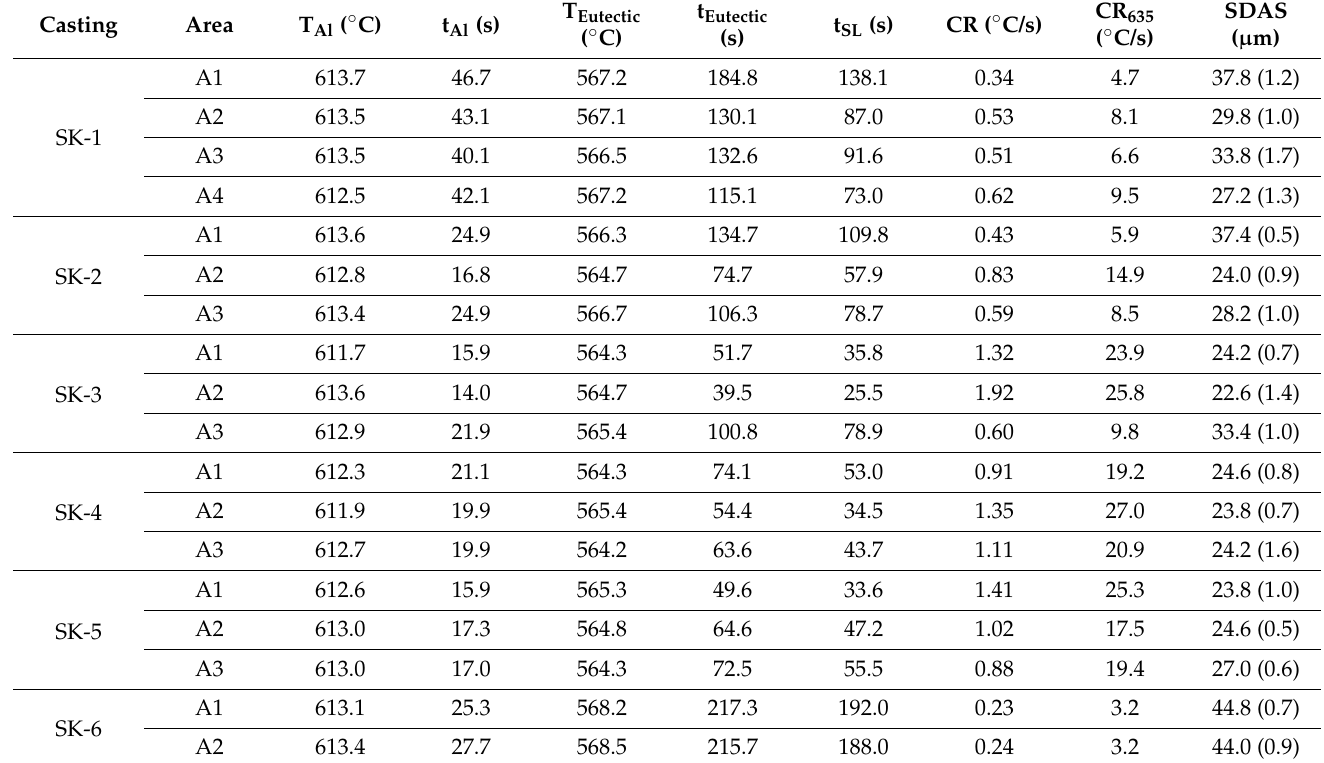
Table 6. Individual values of the solidification parameters determined from the simulated cooling curves obtained in each area of castings SK-1 to SK-6, of t SL , CR and CR 635 and of the experimentally measured SDAS (standard deviation values are shown between brackets for this last